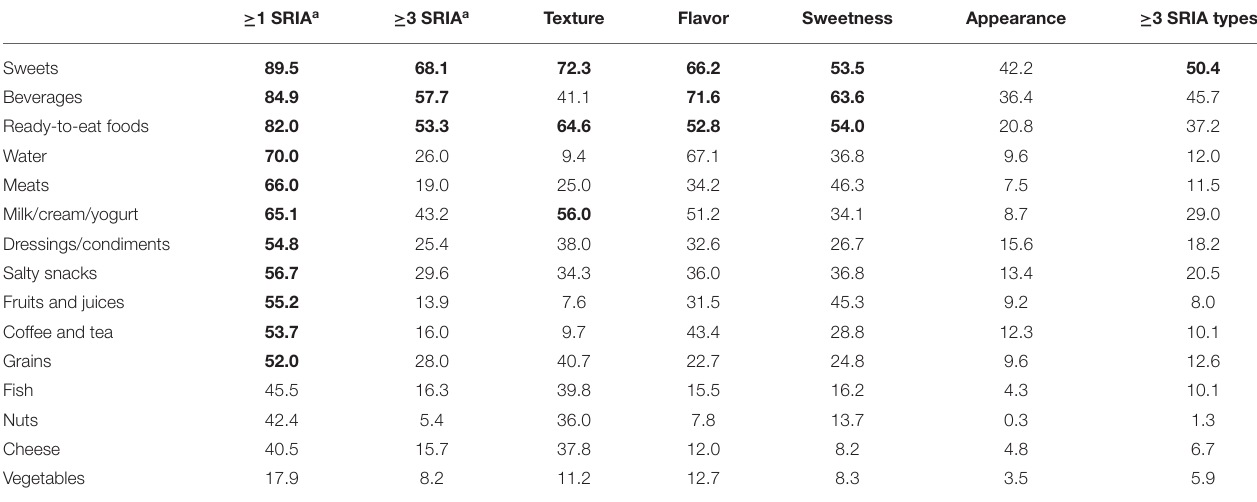
TABLE 4 | Prevalence (%) of sensory-related industrial additives (SRIA) in food items in the Branded Food Products Database, by food group ( n = 224,098). ≥ 1 SRIA a Texture Flavor